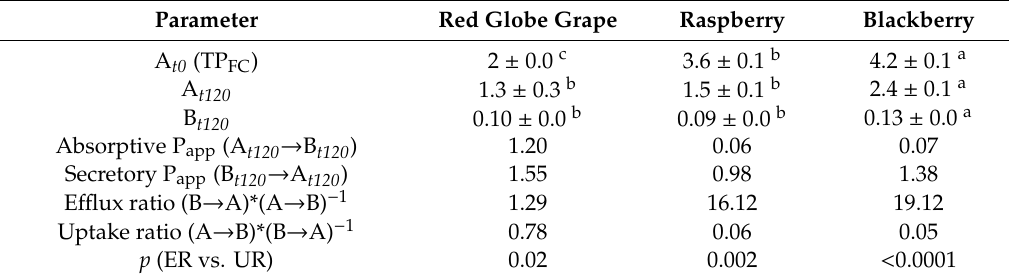
Table 2. Apparent permeability of phenolic compounds from selected berries. 1,2.